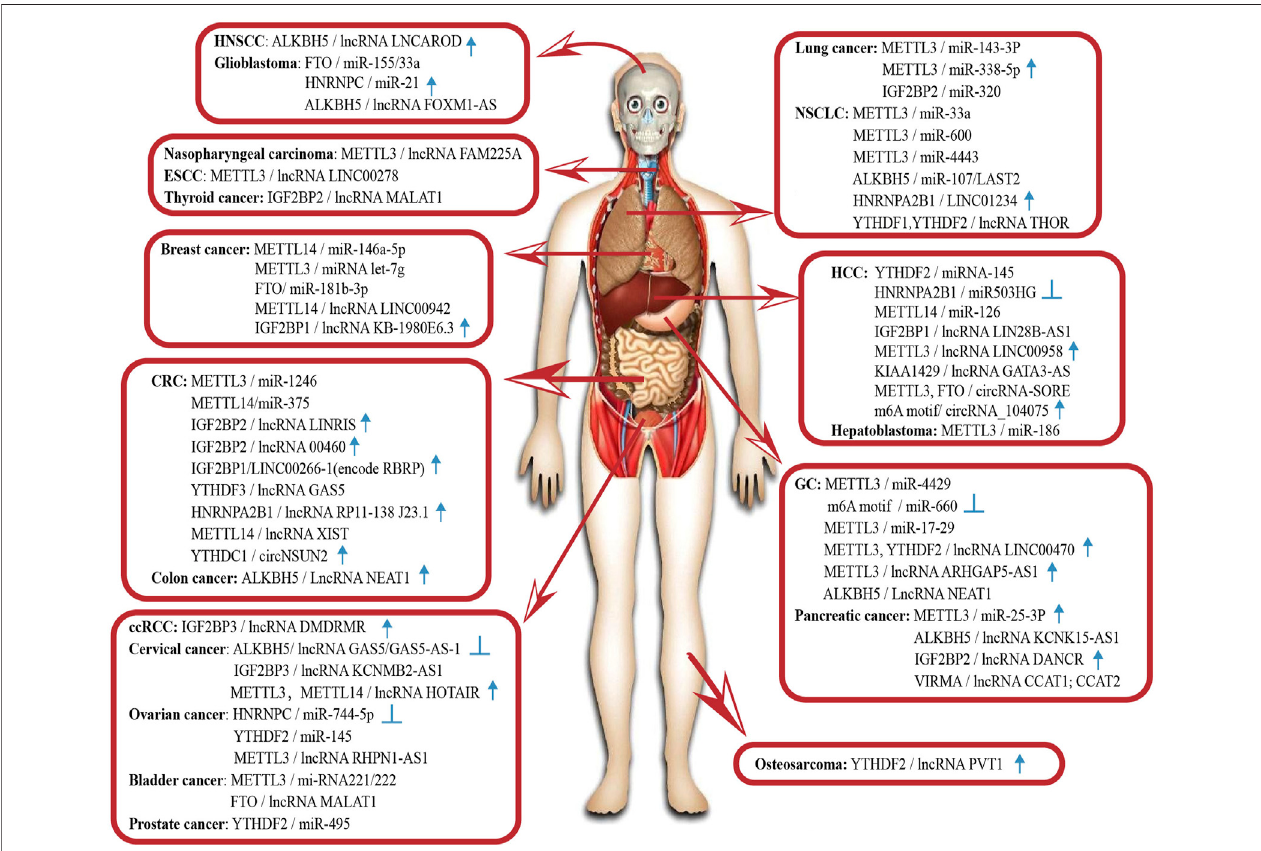
FIGURE2| Abnormalm6Amodi fi cation ofnon-coding RNAinhuman cancers.HNSCC, headand neck squamous cellcarcinoma; ESCC, esophagealsquamous cell carcinoma; HCC, hepatocellular carcinoma; CRC, colorectal cancer; NSCLC, non-small-cell lung carcinoma; GC, gastric cancer; ccRCC, clear cell renal cell carcinoma. The icons represent the ncRNAs that can be regarded as potential diagnostic and prognostic biomarkers. ↑ High expression is positively associated with poor prognosis. High expression is negatively associated with poor prognosis.